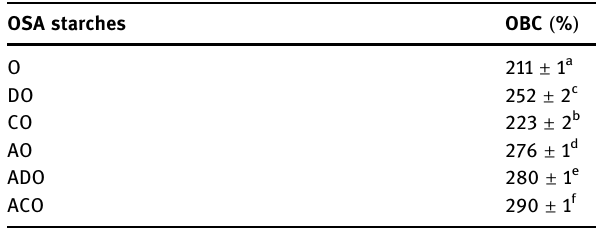
Table 2: OBCs of OSA